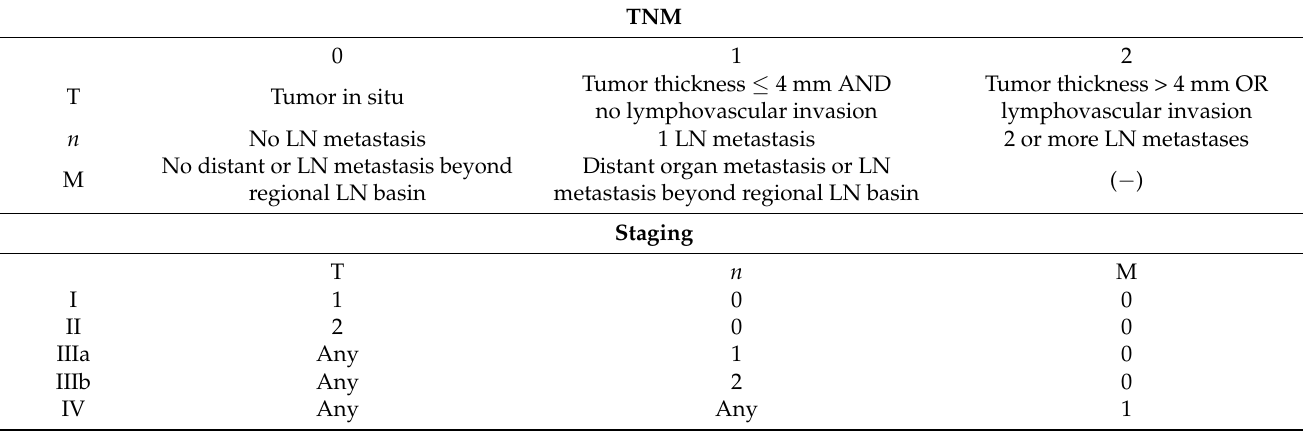
Table 2. Proposed TNM and stage classification system for extramammary Paget’s disease [99].